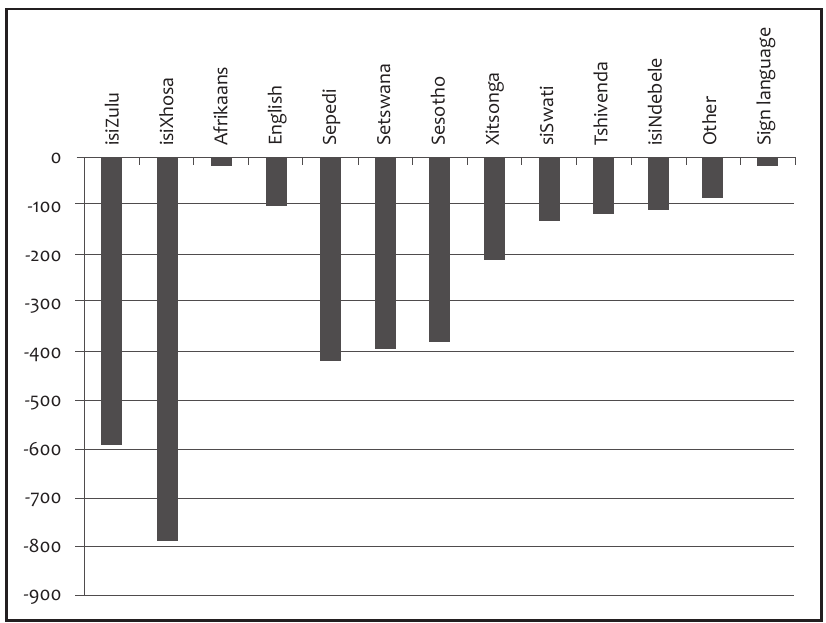
Figure 3: Supply and demand gap in foundation phase teacher graduates per mother tongue,